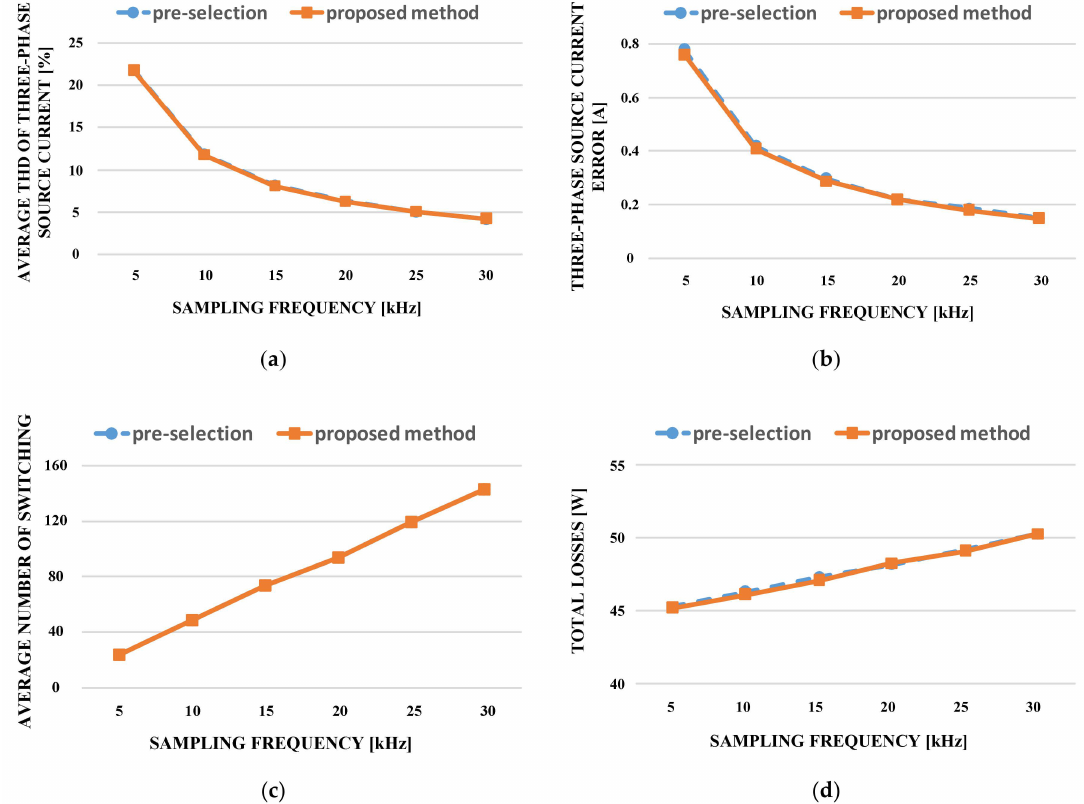
Figure 17. Performance comparison obtained from the pre-selection algorithm and the proposed algorithm vs. sampling frequency: ( a ) Average THD of three-phase source current; ( b ) three-phase source current error; ( c ) average number of switching; and ( d ) total losses ( | v s | = 100 V, V ∗ R s = 1 Ω and L s = 10